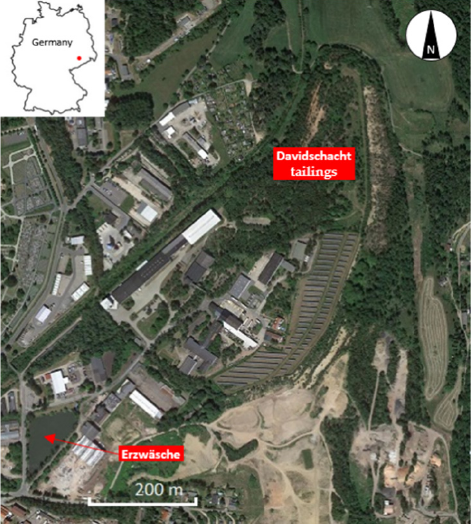
Figure 1. Map and satellite image of the Freiberg Davidschacht tailings dump, Germany (Coordinates: 50°55 ′ 14 ′′ N 13°22 ′ 23 ′′ E). The original satellite image was obtained from Google Earth.